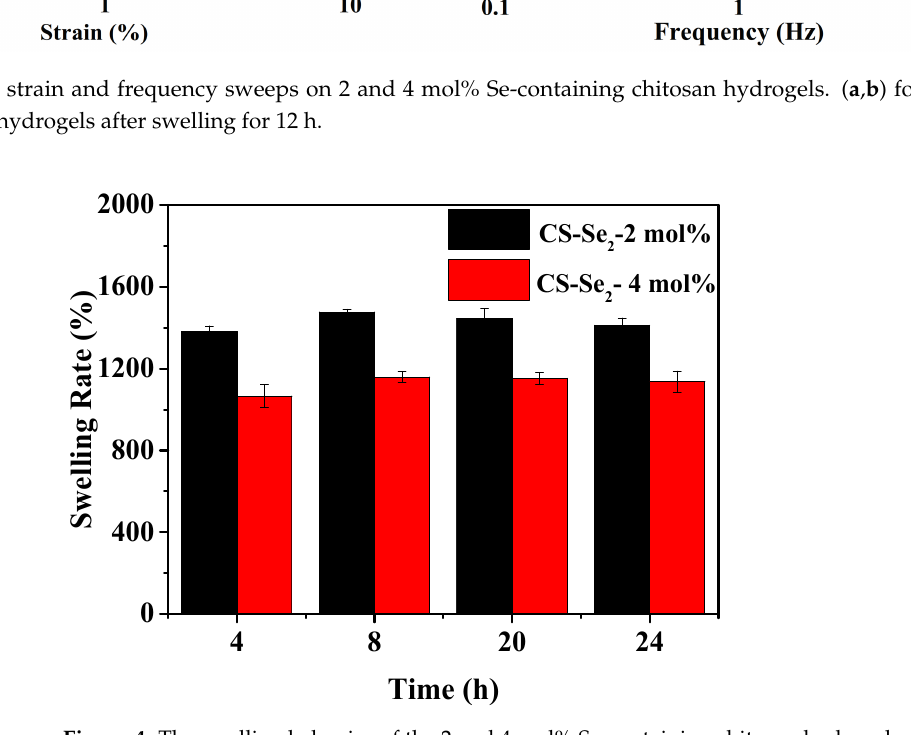
Figure 3. Oscillatory strain and frequency sweeps on 2 and 4 mol% Se-containing chitosan hydrogels. ( a , b ) for 3 wt % hydrogels; ( a’ , b’ ) for hydrogels after swelling for 12 h.